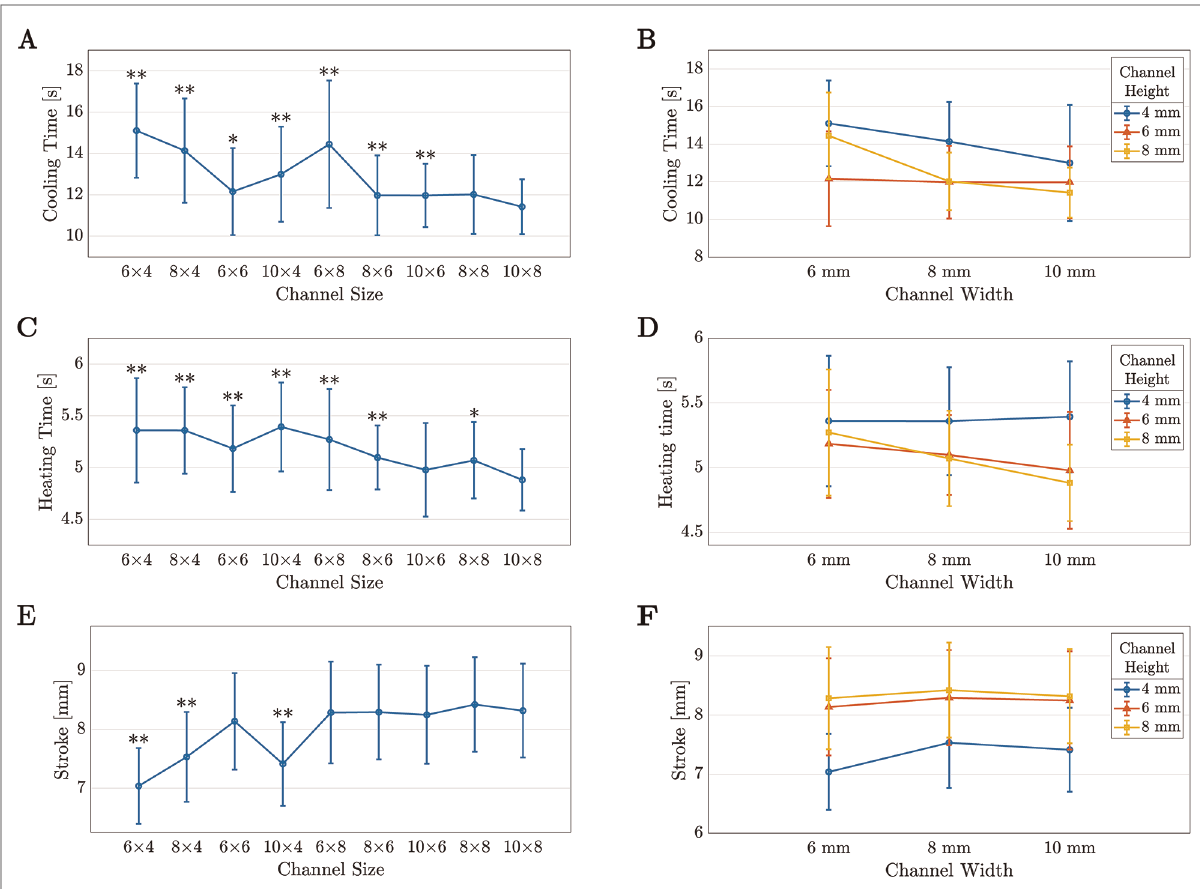
FIGURE 7 The means and standard deviations for the data from Phase I plotted with respect to increasing cross-sectional area ( A , C , E ) and height and width ( B , D , F ). In ( A ), ( C ), and ( E ), statistically signi fi cant differences with the 10 (cid:3) 8 pouch are marked by an (cid:4) for p , 0 : 05 or (cid:4)(cid:4) for p , 0 :